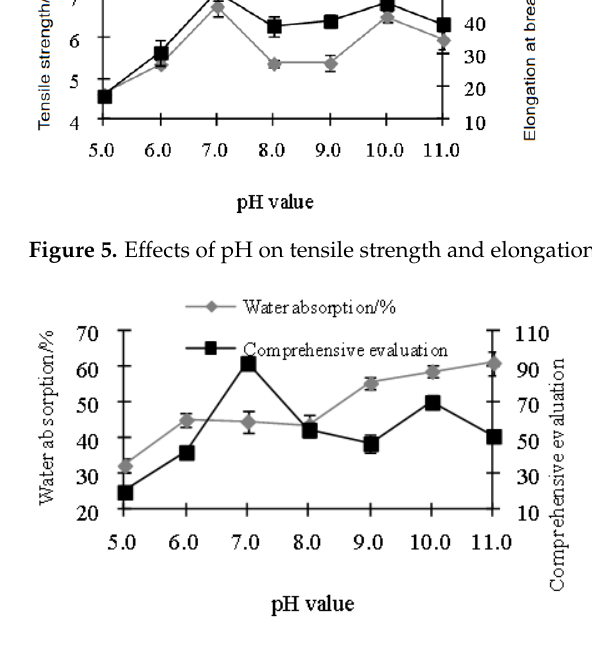
Figure 6. Effects of pH on water absorption and comprehensive evaluation.